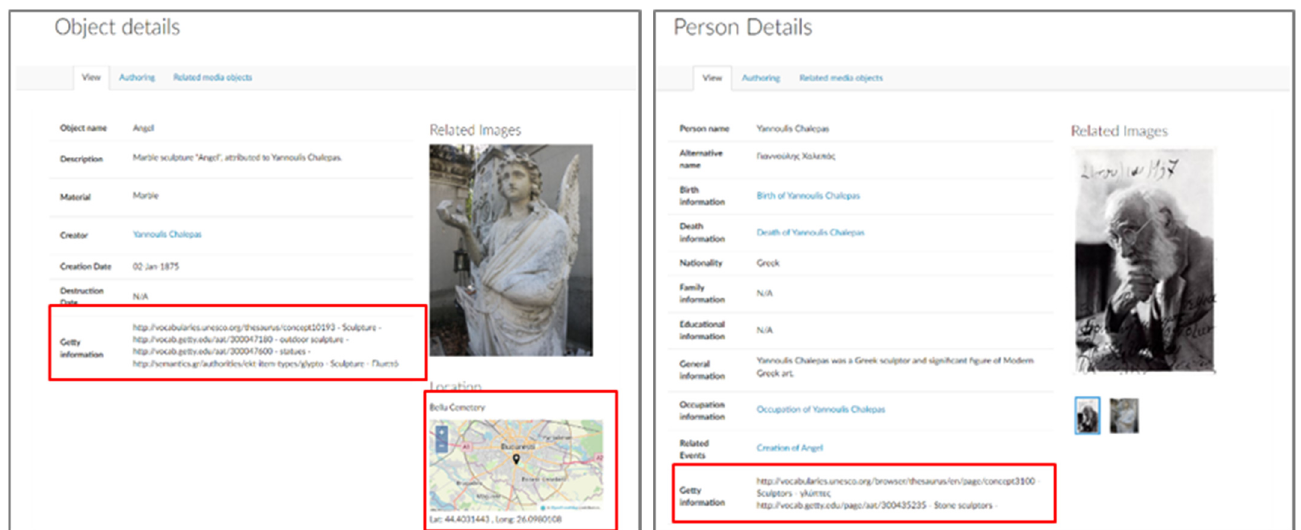
Figure 4. Screenshots showing the extension of the knowledge element edit forms to support controlled vocabularies.